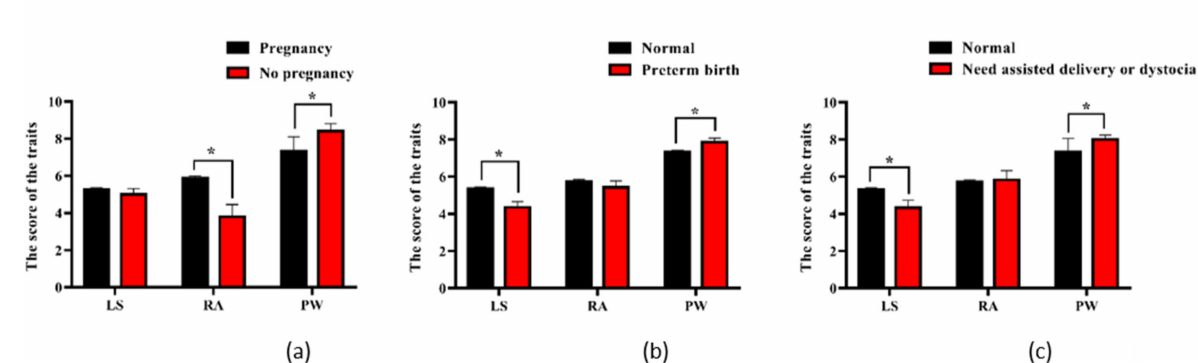
Figure 1. Relationship between the scores of Loin Strength (LS), Rump Angle (RA), and Pin Width (PW), and the reproductive performance, including the occurrence of pregnancy after one breeding ( a ), the occurrence of premature birth ( b ), and the ease of calving ( c ) (mean ± Standard error; the asterisks signify p < 0.05). The Loin Strength (LS), Rump Angle (RA), and Pin Width (PW) scores were related to the reproductive performance of cows.